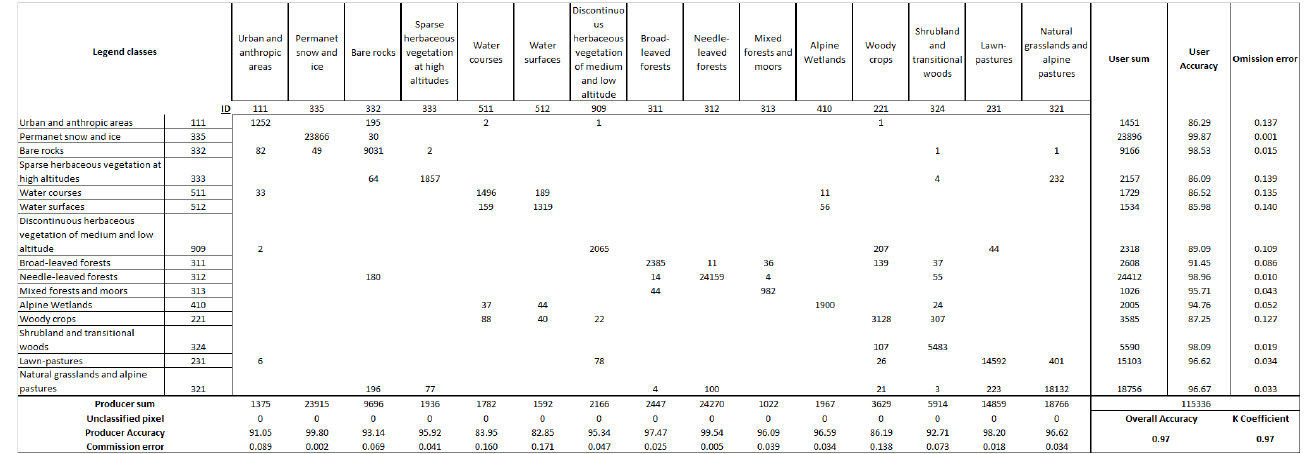
Figure 6. Aosta valley land cover 2020 confusion matrix.